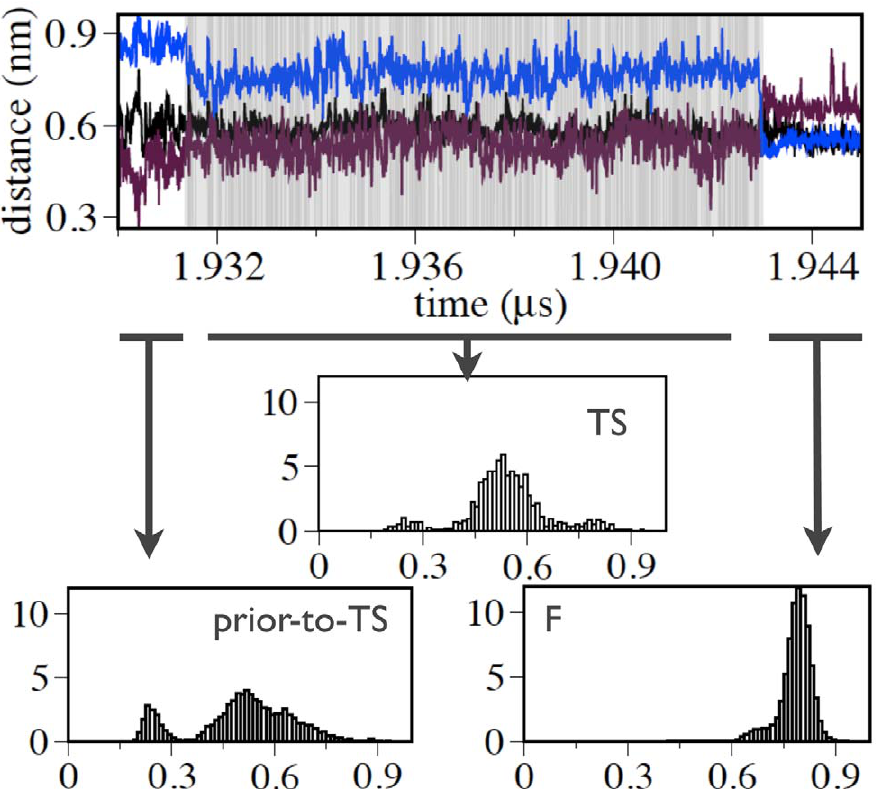
Figure 9. Time evolution of the minimum distance between all the atoms of the W11 sidechain and all the atoms of the P7 sidechain (maroon) for a representative reactive path. In addition, the distances between the C a atoms of the turn (N6-G9) and central (I4- T12) residues are shown in black and blue, respectively. The shaded region represents the TS. The three histograms at the bottom show the distributions of the minimum distances between the W11 and P7 sidechains for the structures sampled before the TS (prior-to-TS), in the TS (TS) and in the native (F) state evaluated over all forward reactive paths. For the prior-to-TS ensemble the structures occurring within 1 ns prior to the TS along all forward reactive paths are